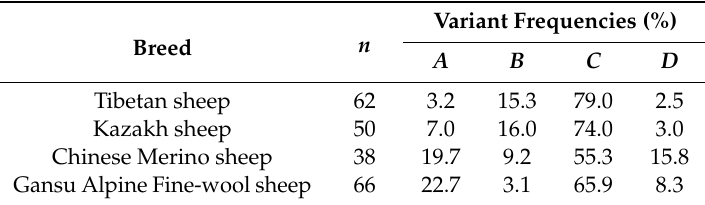
Table 1. Frequencies of ovine keratin-associated protein 2-1 gene variants found in four Chinese sheep